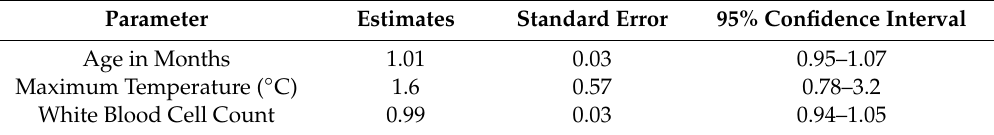
Table 4. Generalized estimate model: factors associated with the presence of UTI.